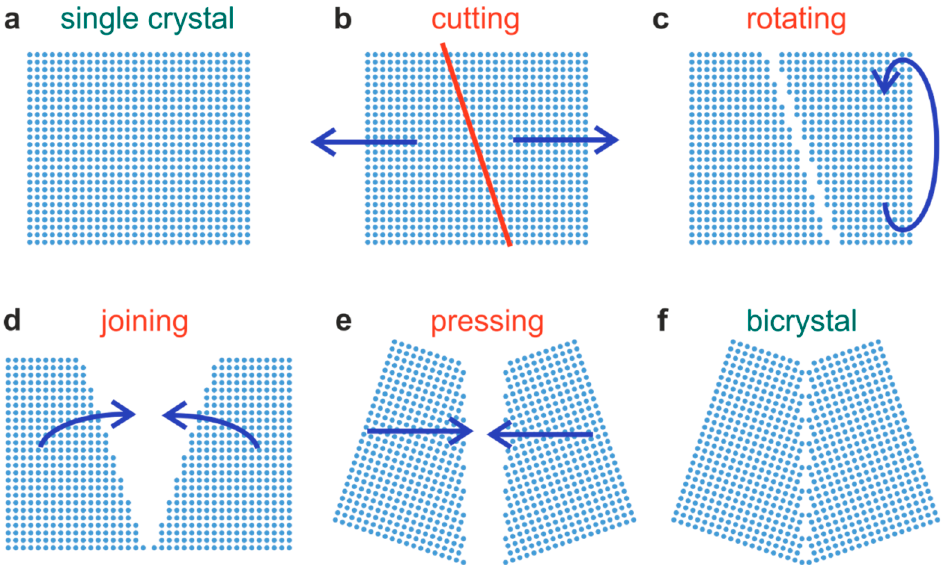
Figure 1. Schematic illustration of the construction of a bicrystal with a Σ 5 boundary. A single crystal ( a ) is cut at an angle of 18.4° ( b ). Then one part is rotated ( c ) and joined to the other part ( d ). Finally, the parts are pressed together ( e ) at high temperatures to obtain the bicrystal ( f ).